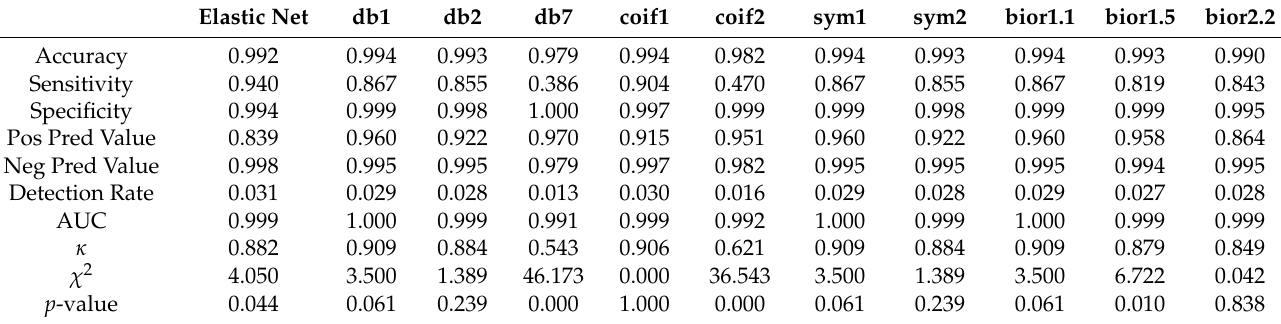
Figure 8. Image reconstruction for one object—example 2.